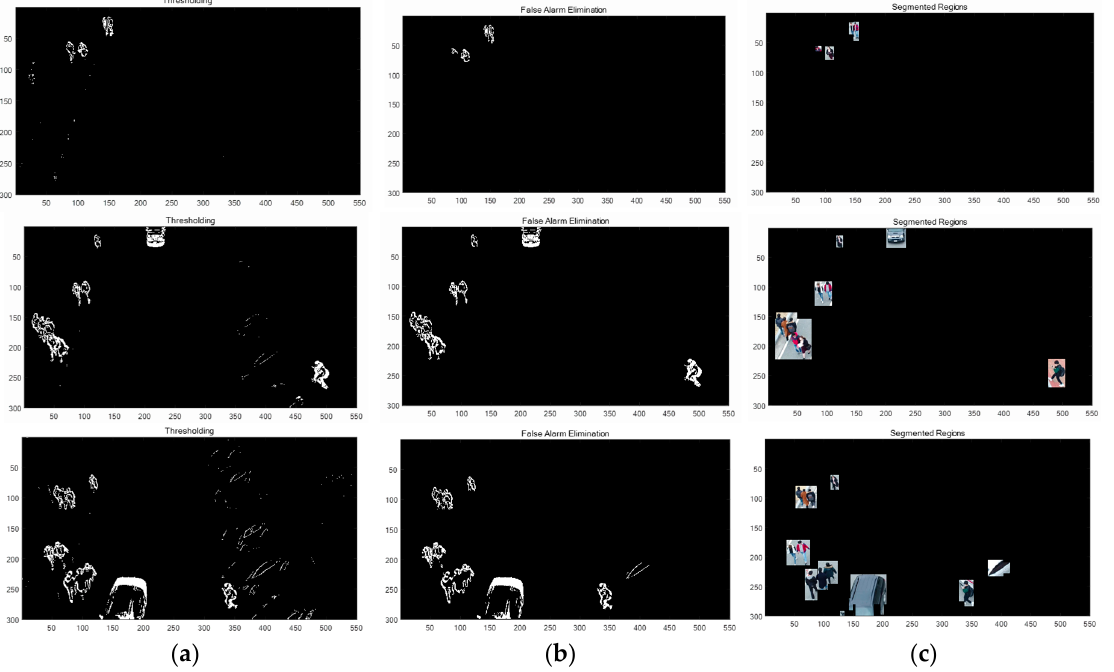
Figure 9. ( a ) Frame subtraction with thresholding, ( b ) morphological filtering and false region removal, ( c ) target region windows.